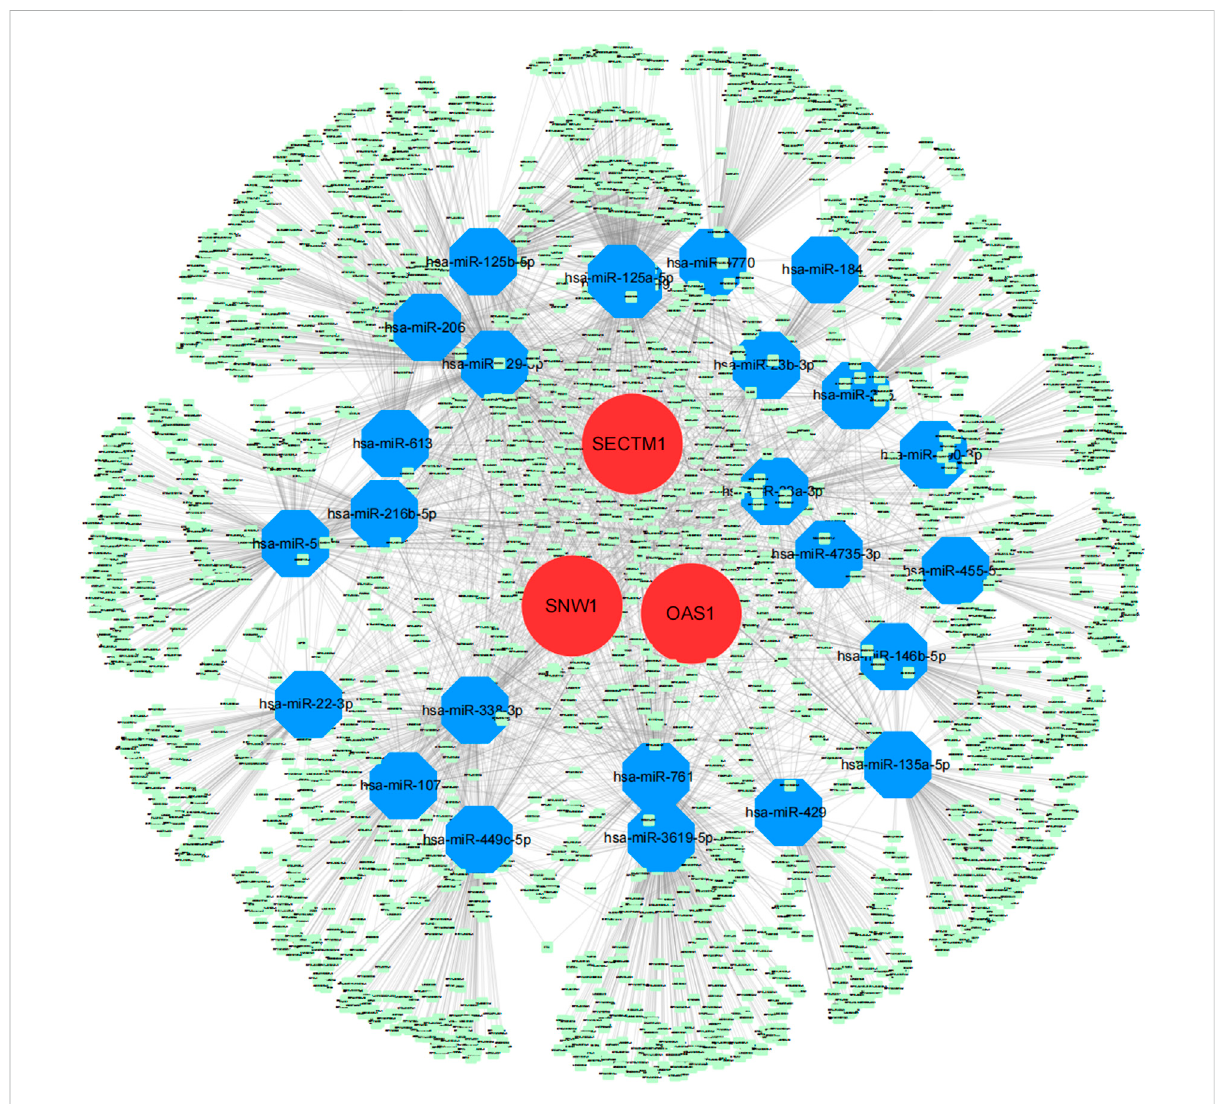
FIGURE 10 Core genes related to the ceRNA regulatory network. Red, blue, and green represent mRNA, miRNA, and lncRNA,